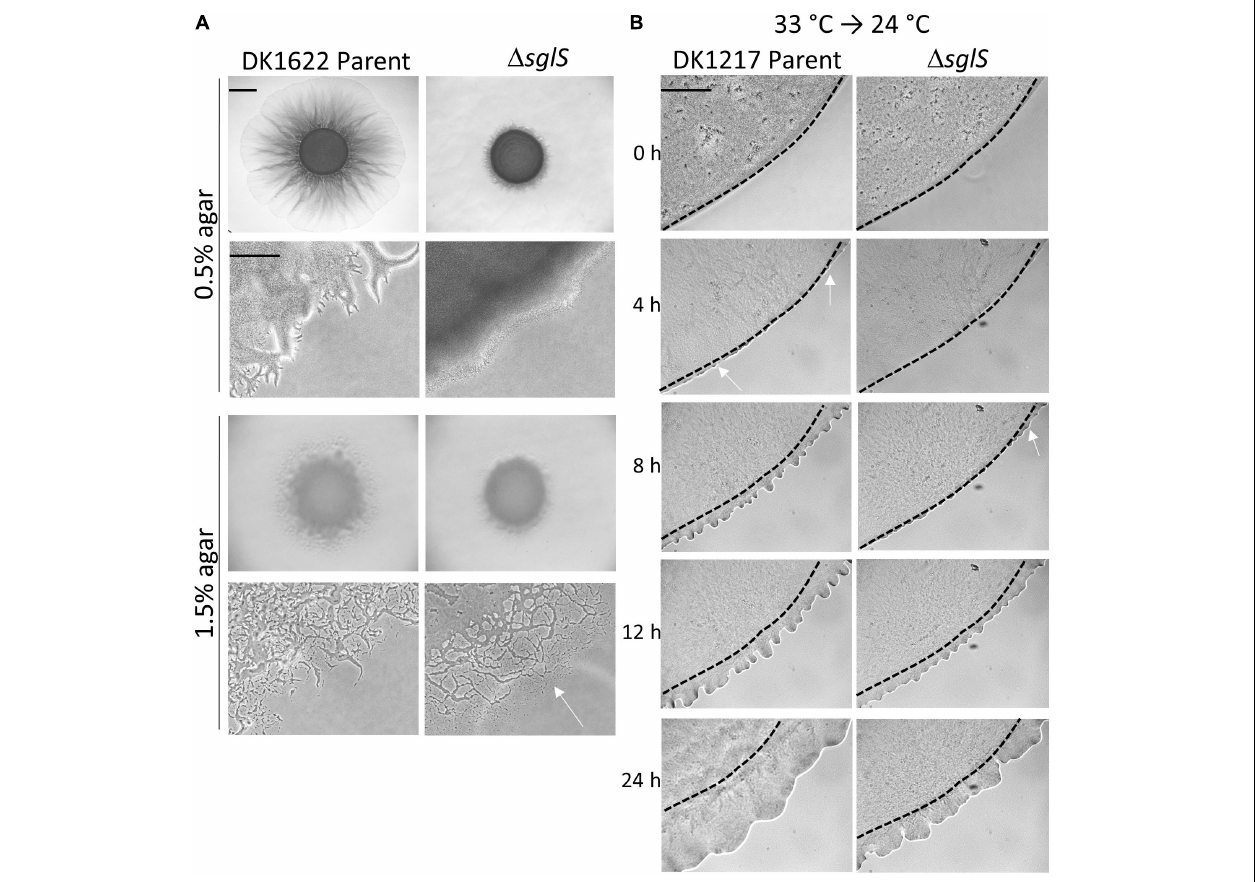
FIGURE 2 | Phenotypic analysis of (cid:49) sglS mutants. (A) (cid:49) sglS mutation affects S-motility, but not A-motility in WT background (DK1622). Plates incubated at 33 ◦ C for 72 h. White arrow shows single cell migration indicative of A-motility. Scale bars, 2 mm and 200 µ m. (B) (cid:49) SglS mutant recovers S-motility following temperature downshift. Strains ( aglB1 background) grown in shaker flask at 33 ◦ C, spotted on CTT soft agar-coated slides and incubated at 24 ◦ C. Phase-contrast micrographs taken at indicated times. Representative micrographs shown from multiple replicates. Initial flare buds marked by white arrows, dashed-lines inoculum edge. Scale bar, 2